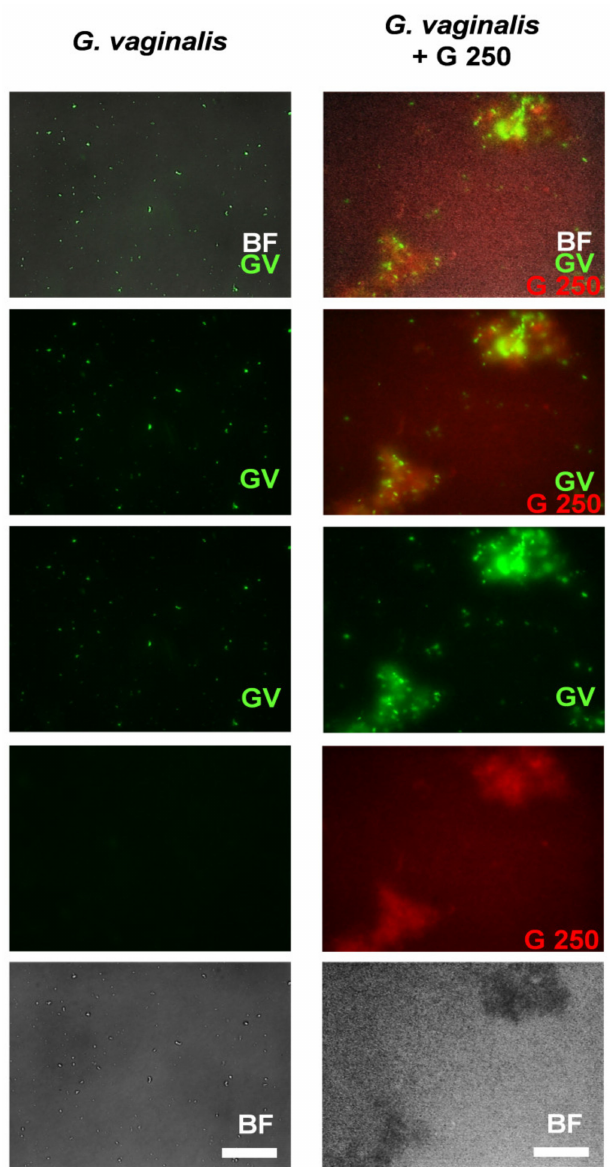
Figure 3. Co-aggregation between L. rhamnosus GG (G 250) and G. vaginalis: G. vaginalis or fluorescein isothiocyanate-labeled (FITC)- G. vaginalis (10 9 CFU / mL) in 500 µ L of phosphate-buffered saline (PBS) were mixed or not with equal volumes of G 250 or RHB-G 250 (G 250) (10 9 CFU / mL). The samples were vortexed for at least 10 s and incubated in a 24-well plate for 4 h at 37 ◦ C under agitation. The suspensions were then photographed by fluorescence microscopy. Images are from one experiment (scale bar = 50 µ m, magnification 20 × ). BF = bright field; G. vaginalis (GV) = green; and G 250 (G 250) =